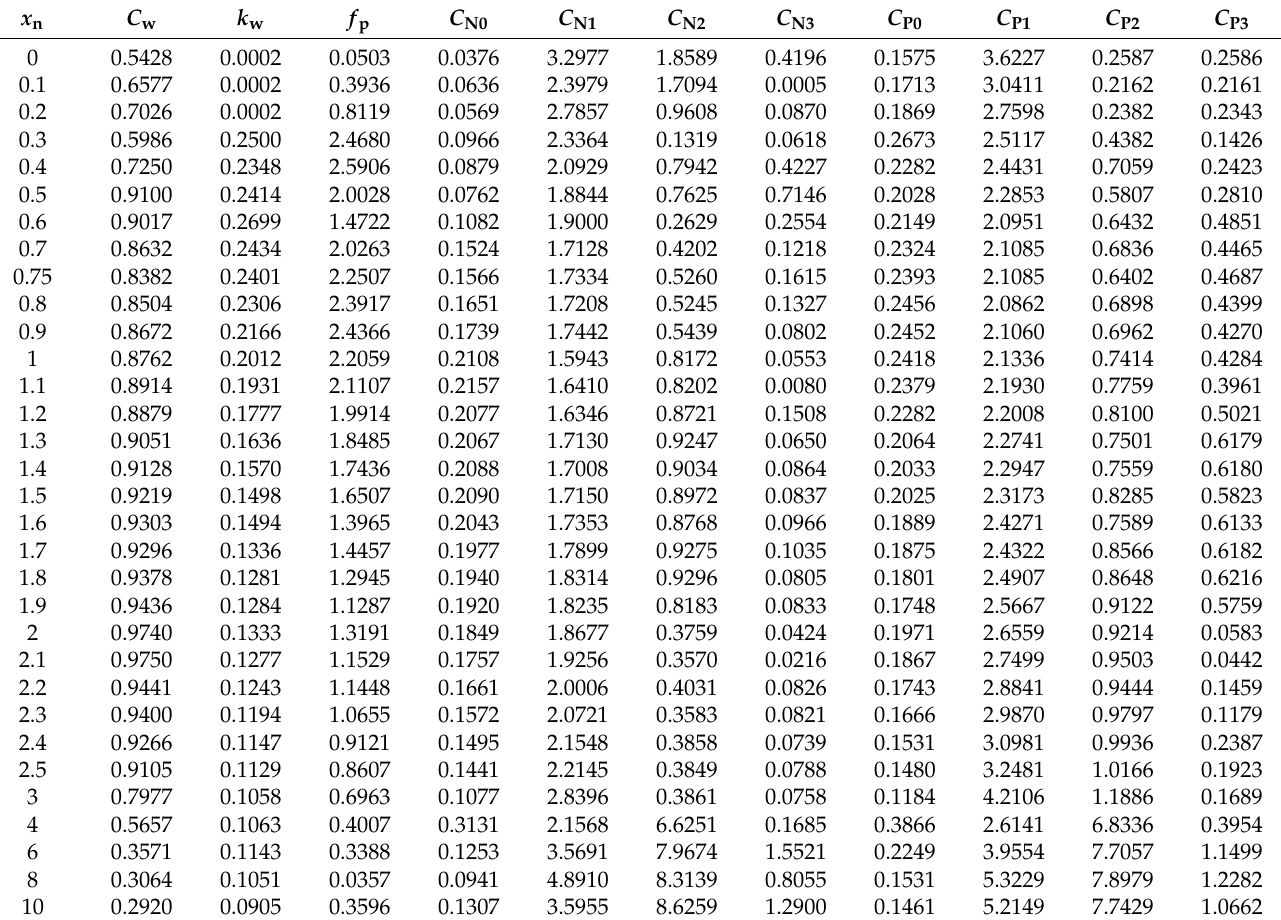
Table A2. The fitting parameters in the ultra-super-Gaussian function, f USG , ( x n ≥